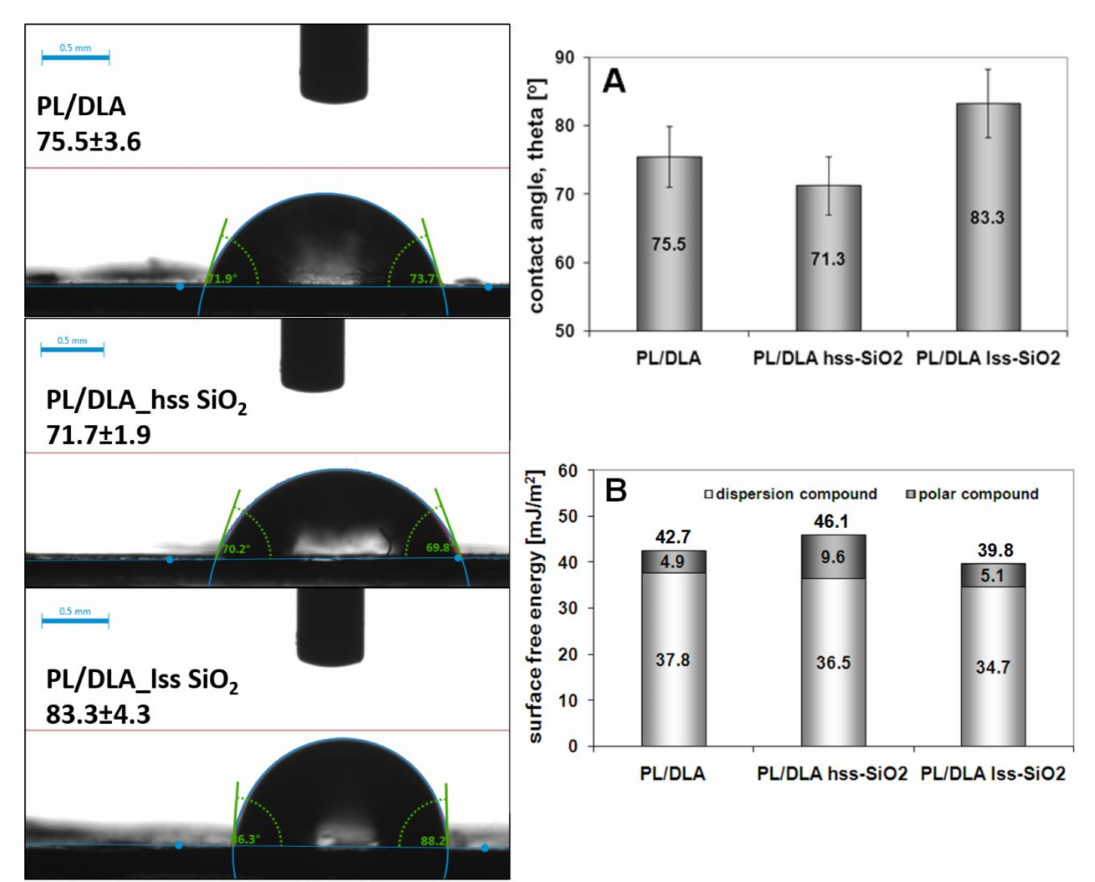
Figure 5. Results of contact wetting angle of the pure polymer and the nanocomposites materials ( A ) and contact angle images of the samples. Surface energy of the pure polymer and the composites ( B